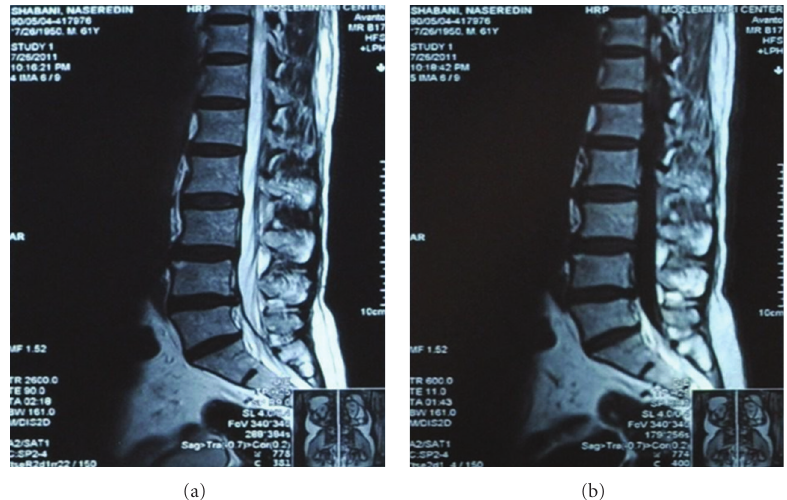
Figure 1: On sagittal T1-weighted (a) and T2-weighted (b) lumbar MR images lumbar degenerative joint change and lumbar disc dehydration with decreased lumbar lordosis is